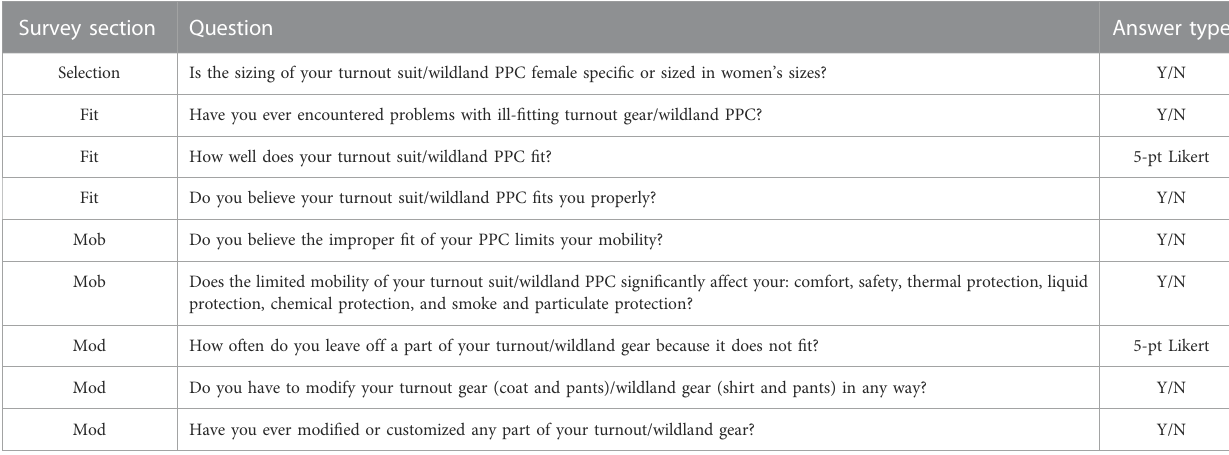
TABLE 1 Female fi re fi ghter user needs questions related to PPE occupational exposure. Survey